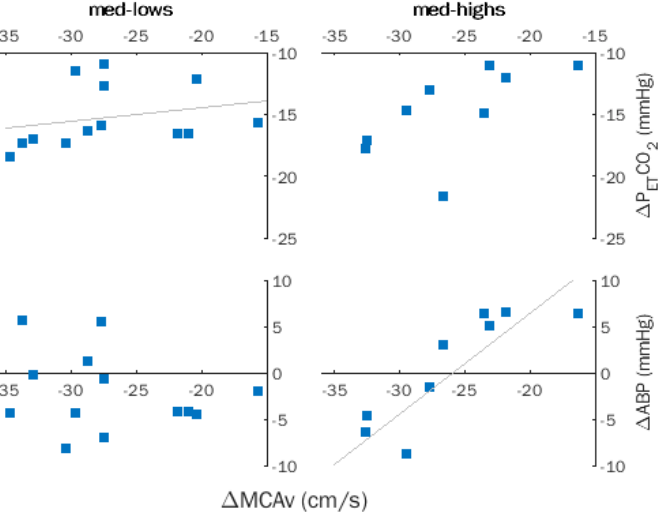
Figure 3. Hyperventilation (HVT). Within-group correlations between changes in middle cerebral artery flow velocity (MCAv), partial pressure of end-tidal CO 2 (P ET CO 2 ), and arterial blood pressure (ABP) in med-lows and med-highs. Trendlines indicate significant correlations. Table 2. Derived Doppler